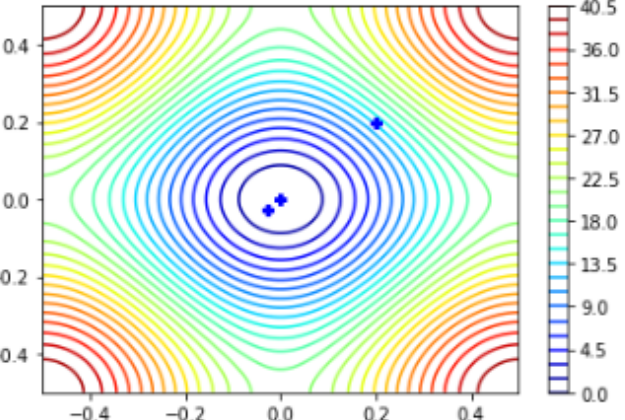
Figure 10. Global minima of the Rastrigin function using q -BFGS algorithm.